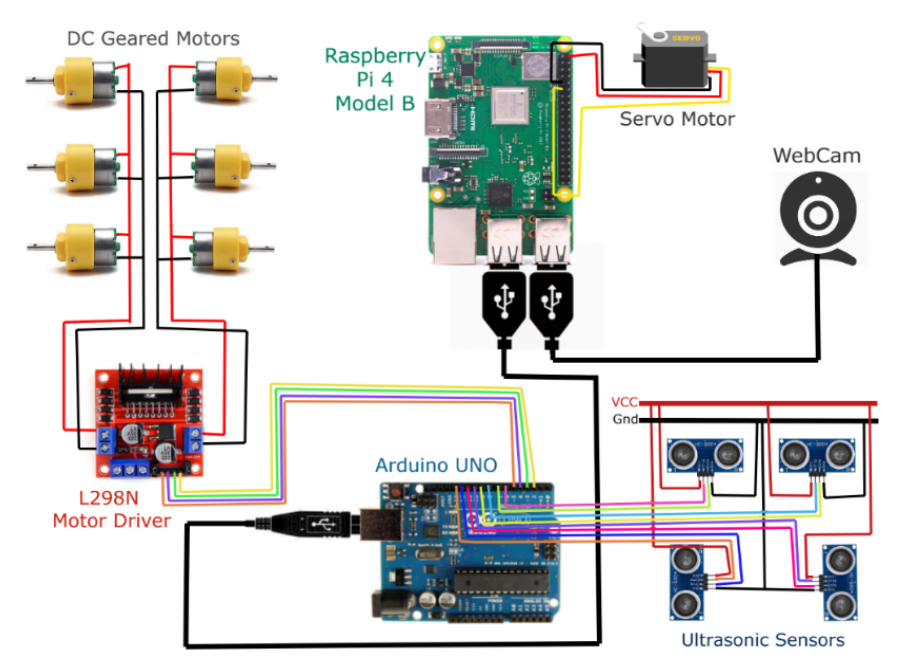
Figure 4. Circuit Diagram: part B.